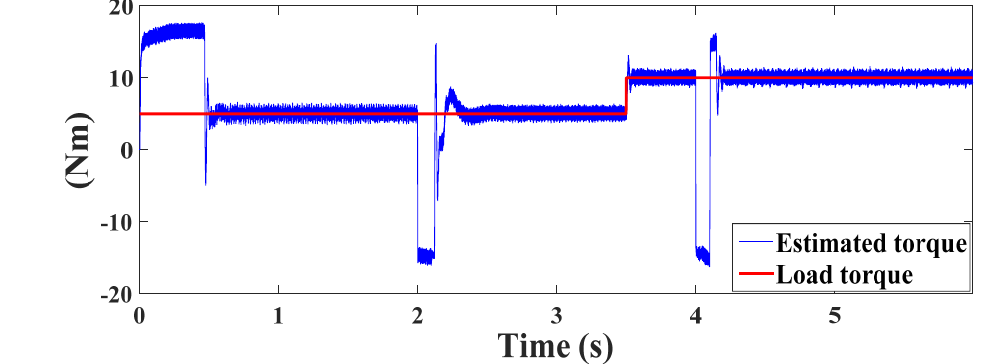
Figure 15. Torque profile under proposed PVC approach (Nm). Figure 14. Rotor speed profile under proposed PVC approach (RPM).